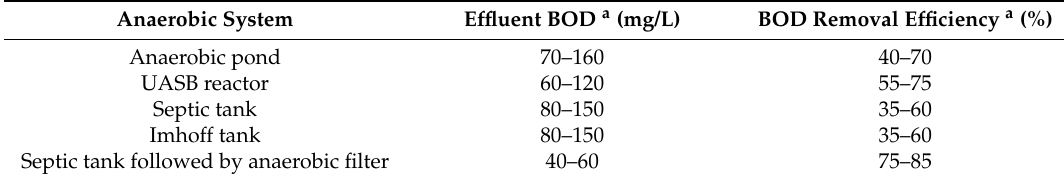
Table 1. Removal efficiencies in anaerobic systems treating domestic sewage